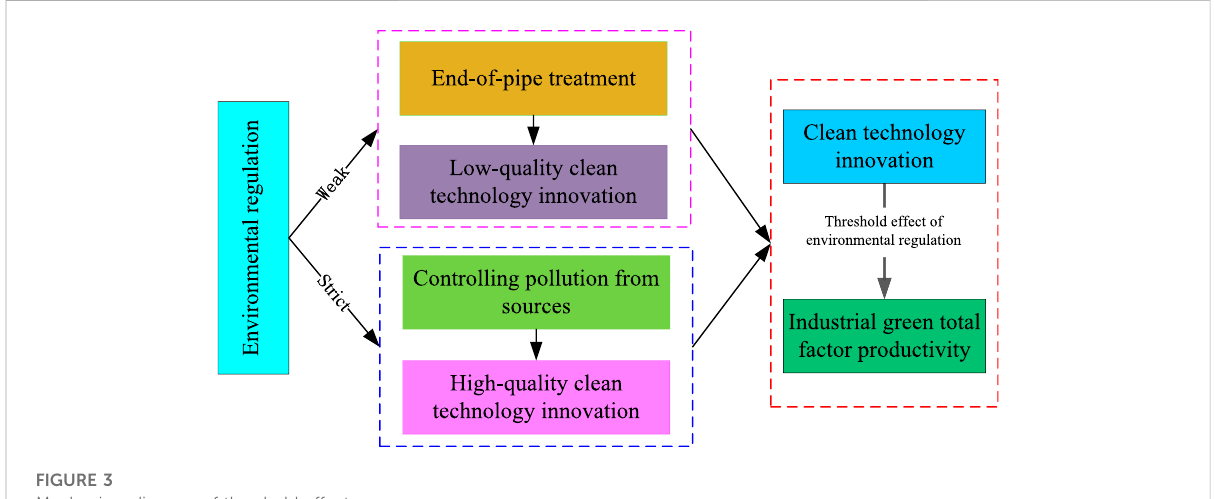
FIGURE 3 Mechanism diagram of threshold